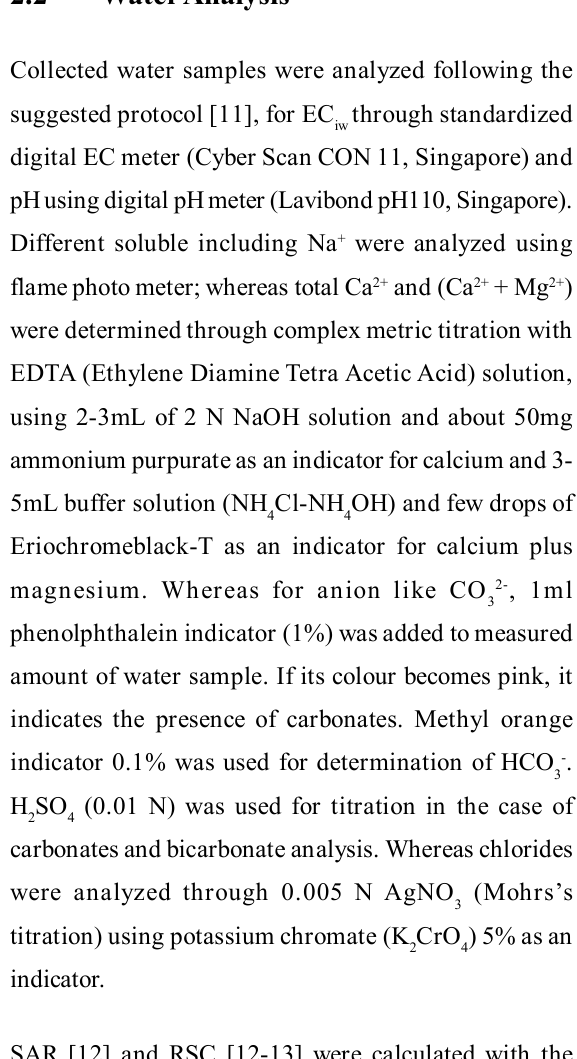
TABLE 1. WATER QUALITY CRITERIA BASED ON EC